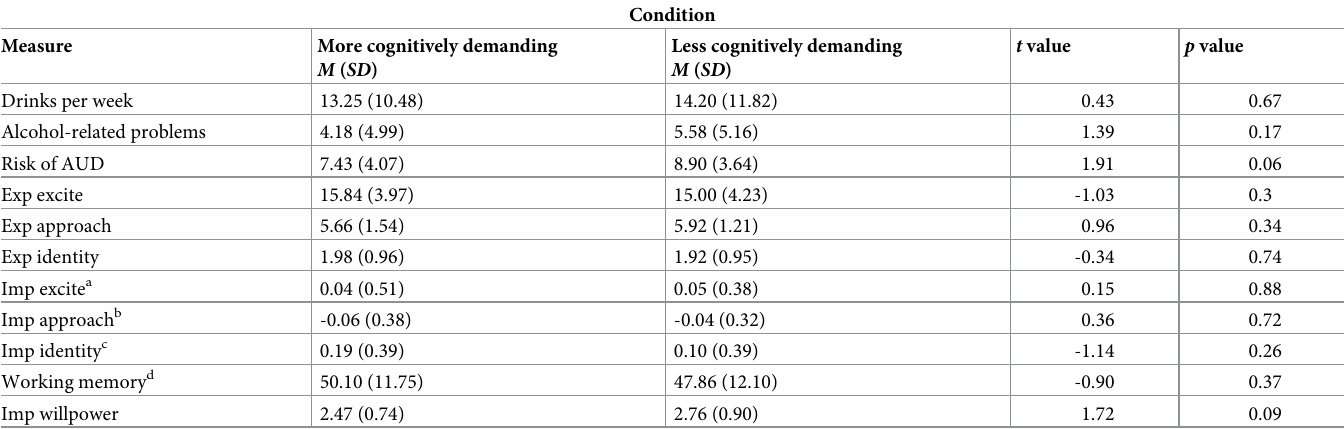
Table 1. Baseline data stratified by